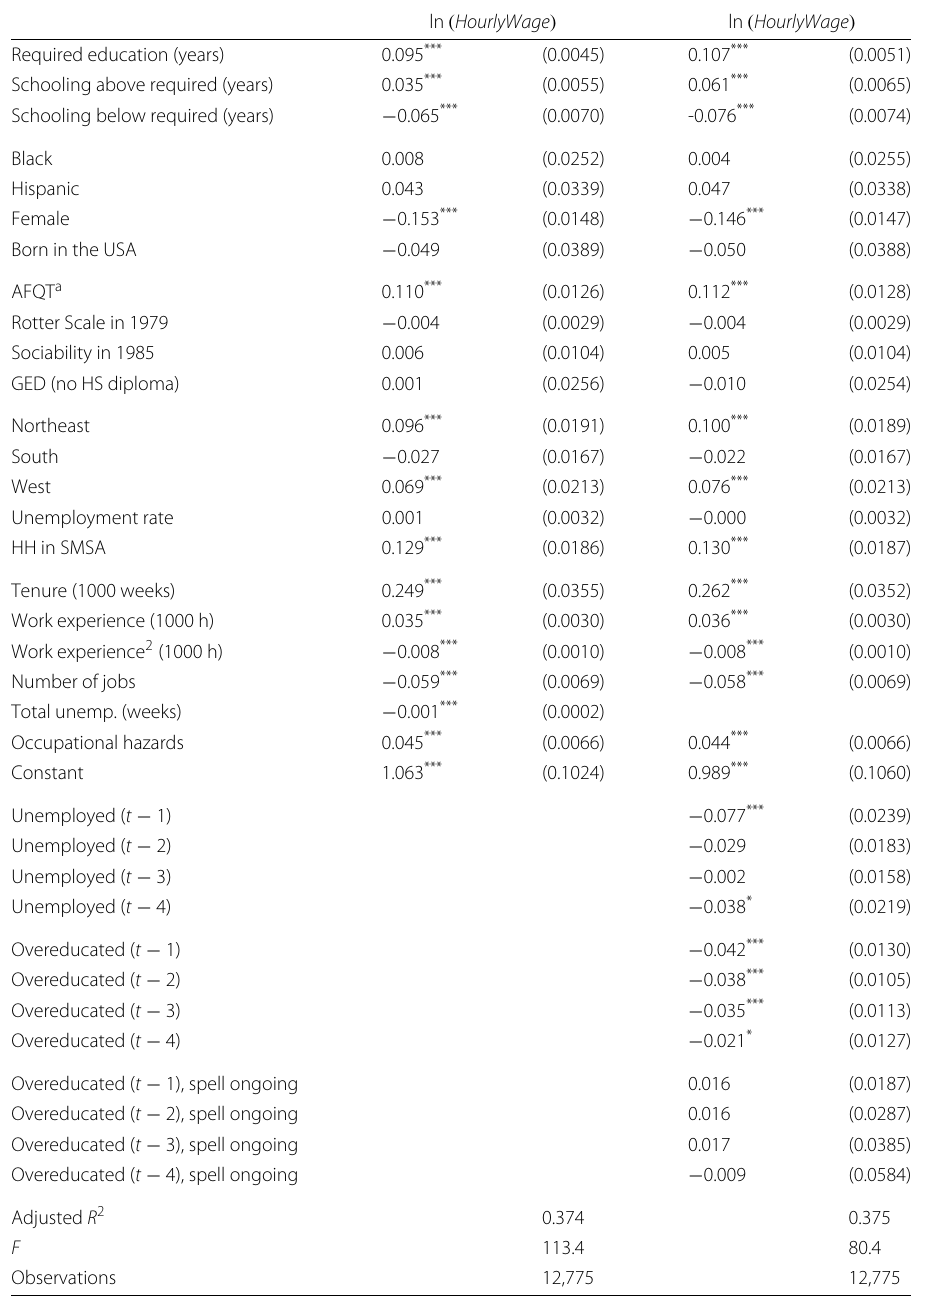
Table 10 Augmented log-wage